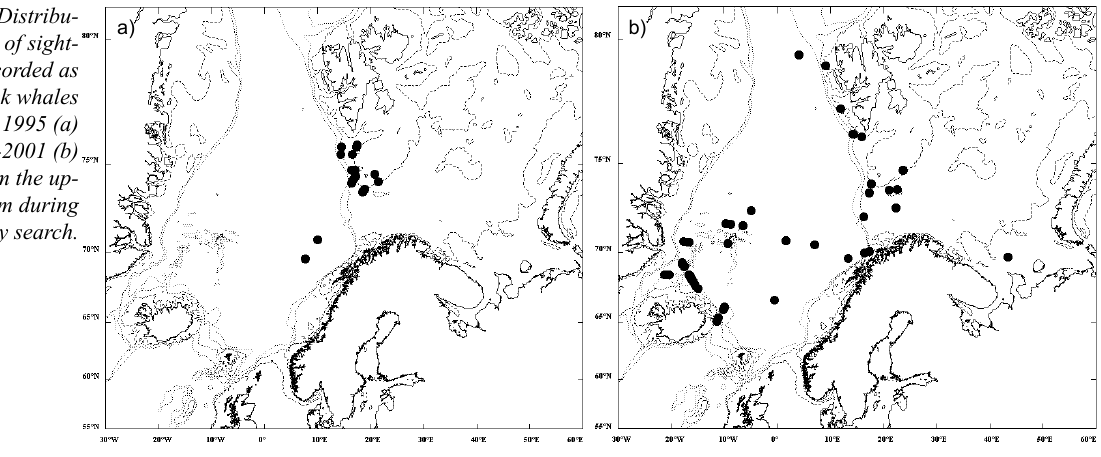
Fig.3. Distribu - tions of sight- ings recorded as humpback whales during the 1995 (a) surveys from the up - per platform during primary